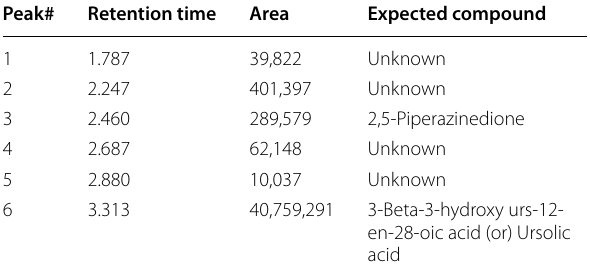
Table 1 HPLC chromatogram of Trichoderma viride extract at 200 nm Peak# Retention